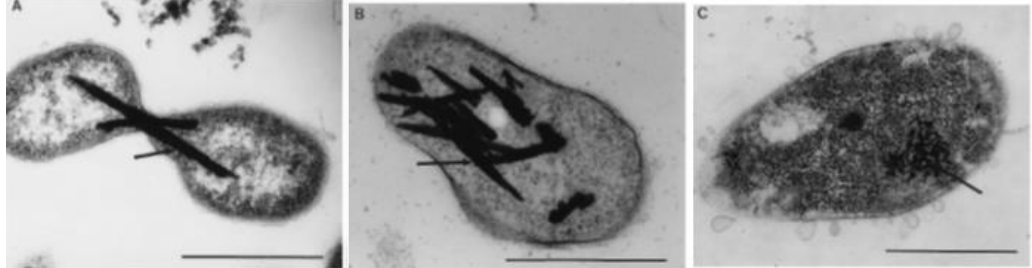
Figure 8. Electron microscopy of ultrathin sections. Shown are the intracellular localizations of presumed tellurium (indicated by arrows) as a product of tellurite reduction. ( A ) Two daughter cells of E5 with tellurium crystals apparently interfering with cell division. ( B ) In T4, tellurium crystals sometimes occupy as much as 20% to 30% of the cell volume. ( C ) RB3 accumulates relatively small Te crystals similar to Te deposits observed in E. coli or Rhodobacter species. Scale Bars, 0.5 mm. [15].